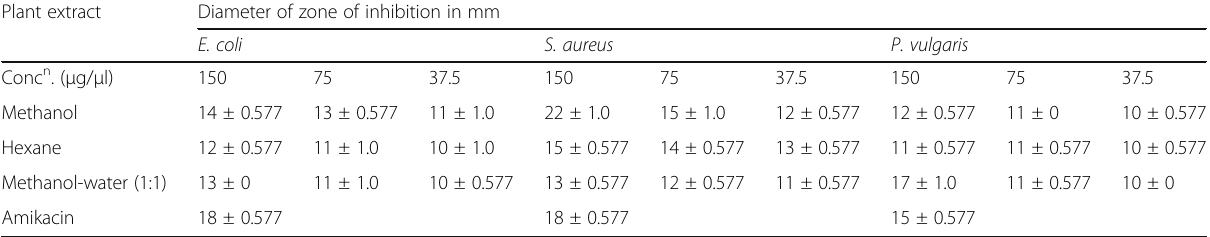
Table 4 Antibacterial data of methanol, hexane, and methanol water (1:1) extracts of D. diandra in DMSO Plant extract Diameter of zone of inhibition in mm